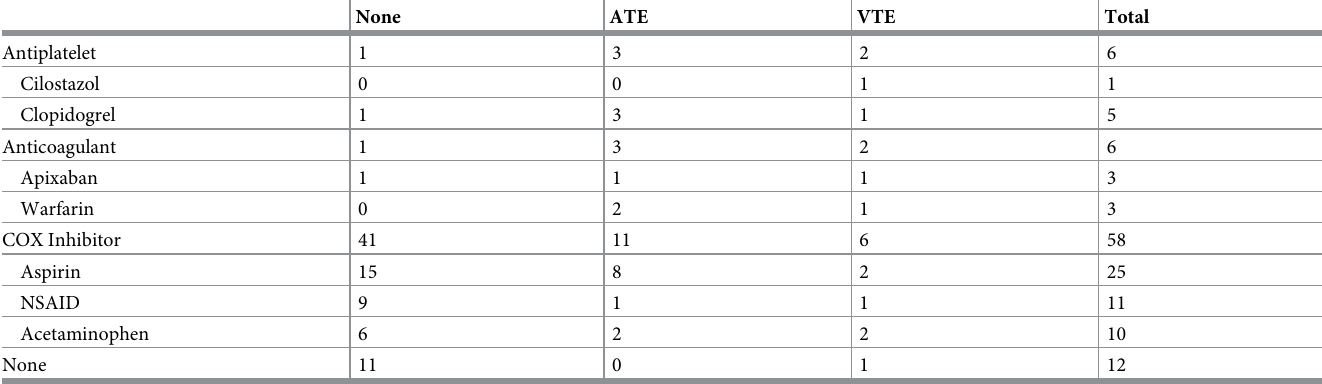
Table 3. Antiplatelet and anticoagulant